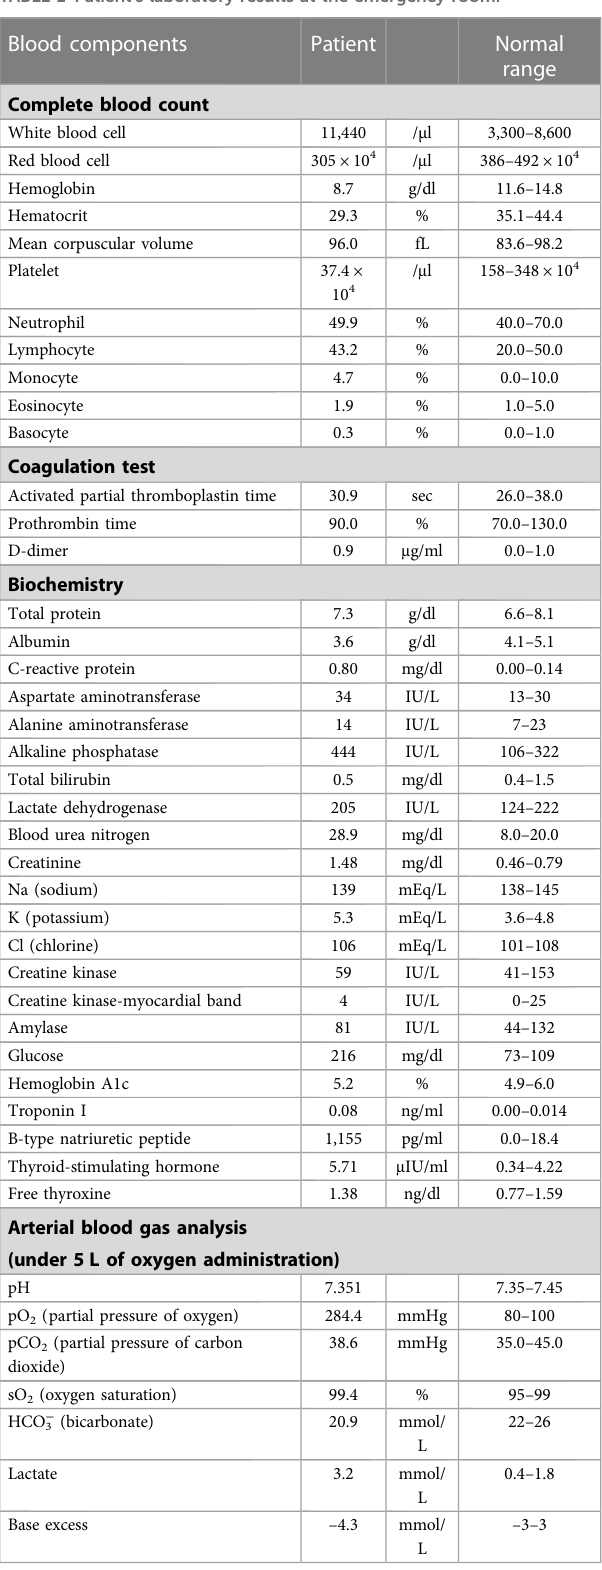
TABLE 1 Patient ’ s laboratory results at the emergency